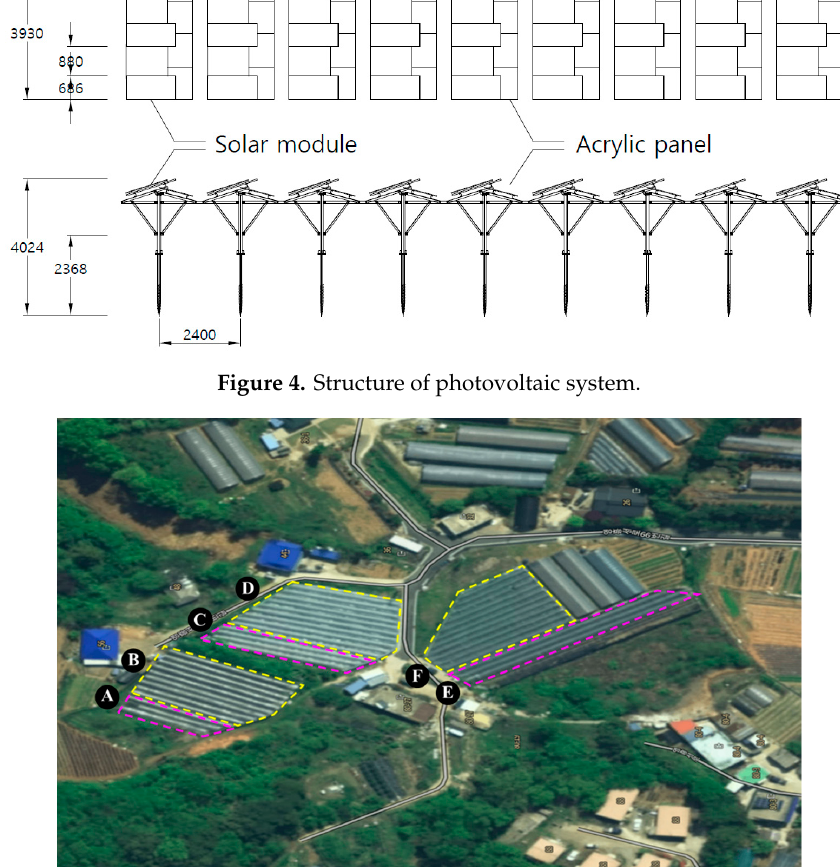
Figure 4. Structure of photovoltaic system.